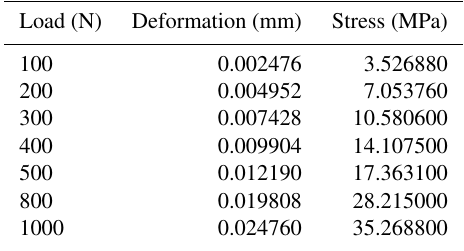
Table 1. Deformation and stress of the hammer slice under different